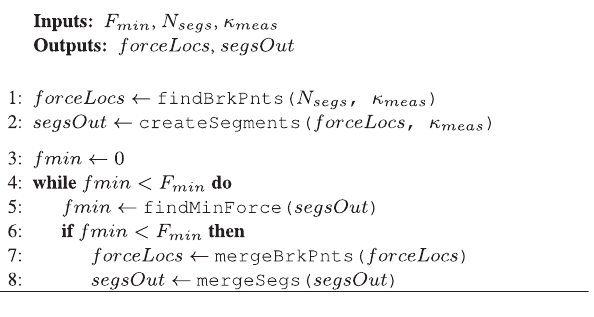
Algorithm 2 Force magnitude thresholding